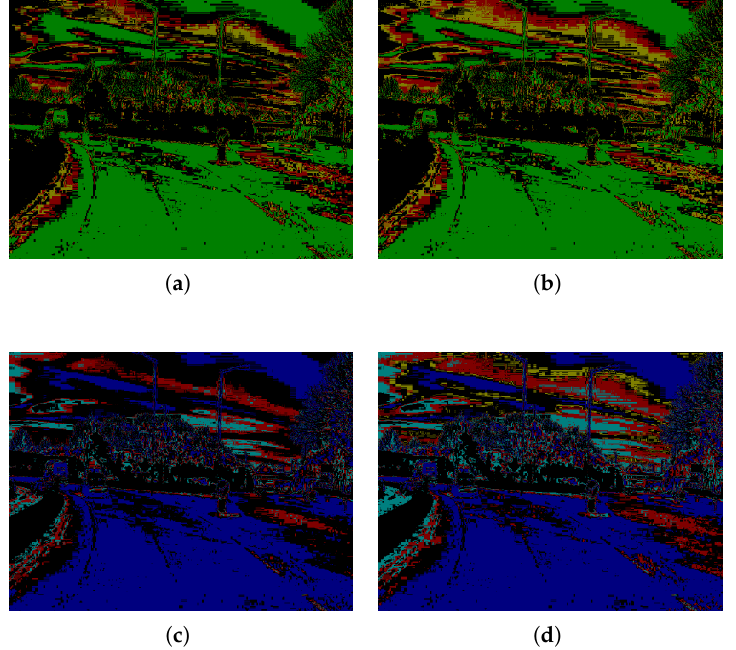
Figure 7. CamVid segmented images for different block sizes. ( a ) Block size 16 × 8. ( b ) Block size 16 × 16. ( c ) Block size 32 × 8. ( d ) Block size 32 ×